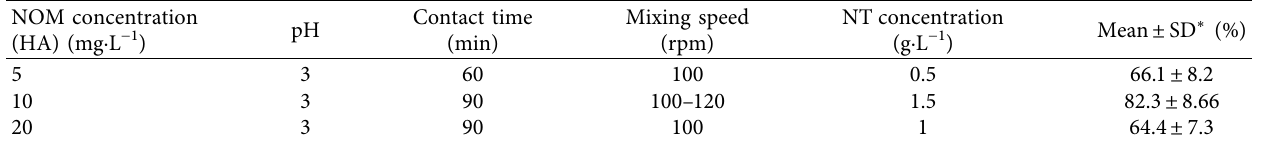
Figure 6: Histogram of carbon nanotubes (a) before and (b) after coating with MWCNTs-Fe Table 6: Removal percentage of HA in synthetic samples at optimal